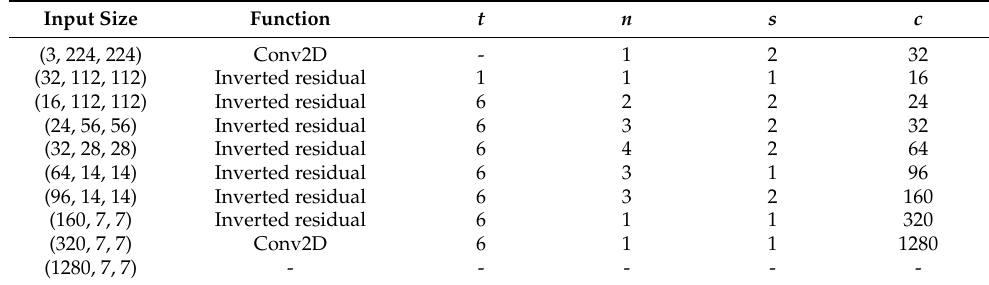
Table 1. The architecture of